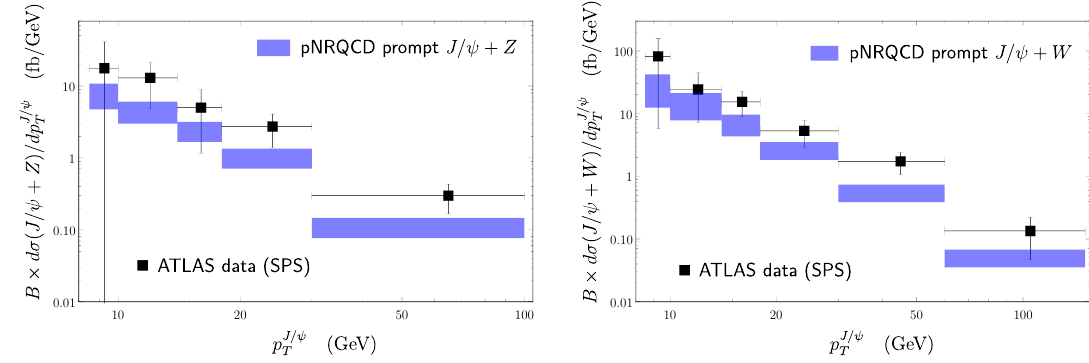
Figure 16 . Production cross sections of prompt J/ψ + Z (left) and prompt J/ψ + W (right) at √ the LHC center of mass energy s = 8 TeV for | y J/ψ | < 2 . 1 in pNRQCD compared to ATLAS data [94, 95]; B is the dimuon branching